Question: Compose a caption that would accompany this figure in a paper.
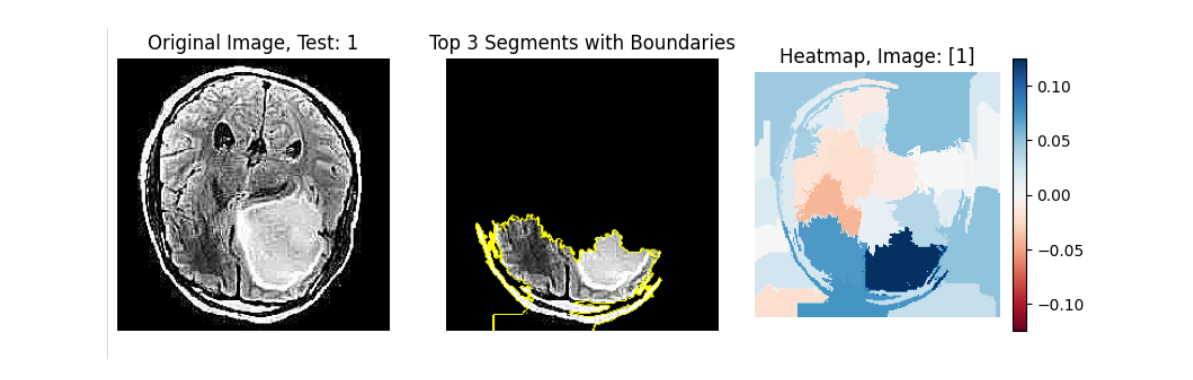
Answer: Top segments contributing to the prediction, with the produced heatmap from LimeImageExplainer